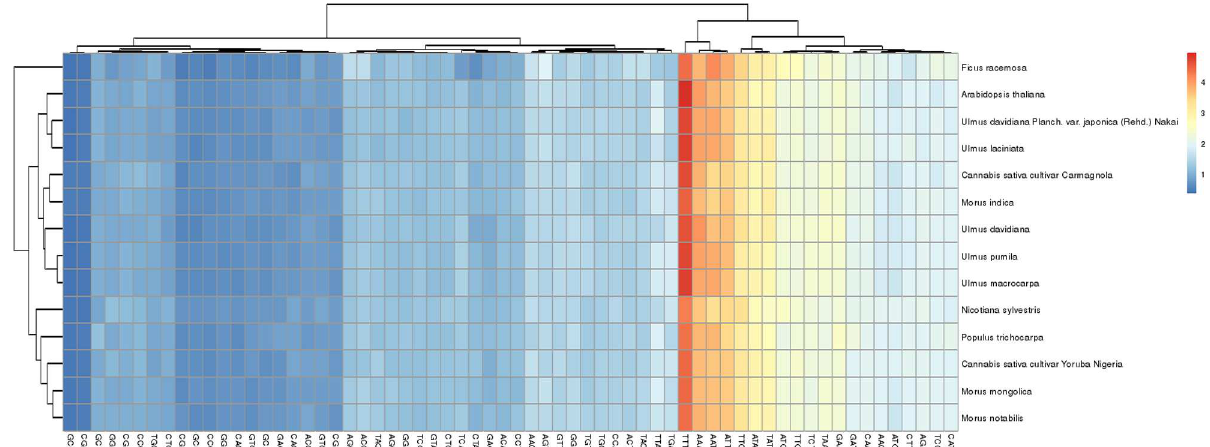
Fig 4. Codon distribution of all merged protein-coding genes. Color key: Red indicatesa higher frequency and blue indicatesa lower frequency. doi:10.1371/journal.pone.0171264.g004 (Fig 6). The Ka and Ks values of all Ulmus species were low ( < 0.1), indicating that the Ulmus chloroplast protein-coding genes are relatively well conserved. Further analysis of Ka/Ks was used to determine whether selective pressure has acted on protein-coding genes. The genes atpH , psbA , psbM , and rps8 in U . davidiana var. japonica were subjected positive selective